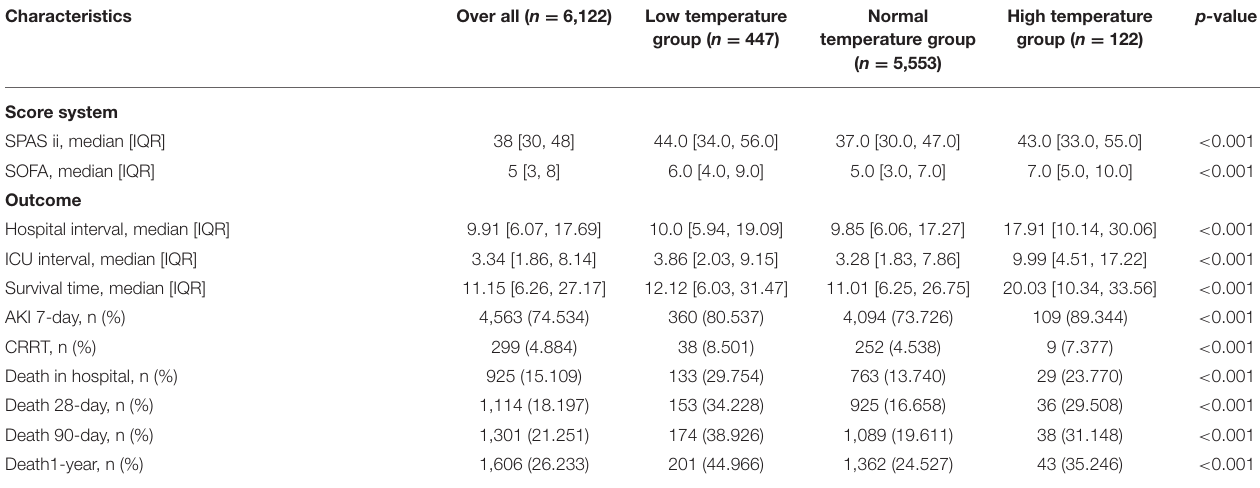
( Table 2 ) across univariate analysis. After adjusting potential confounding factors, the results of multivariate cox analysis and multivariate logistic regression analysis were that